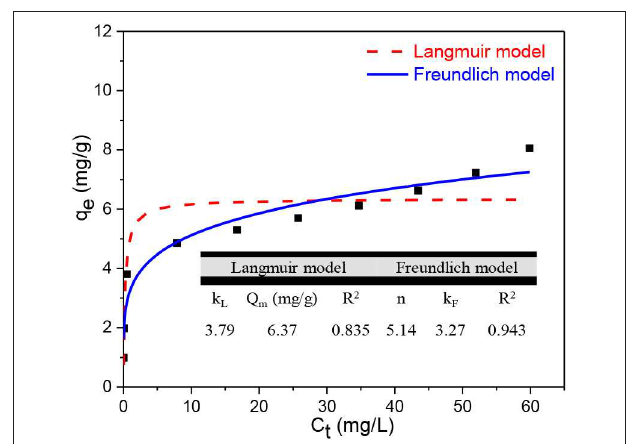
FIGURE 4 | Sorption isotherms of TC using BC800 ( T =